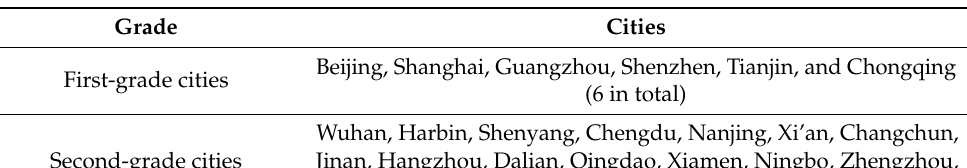
Table 2. City Grade